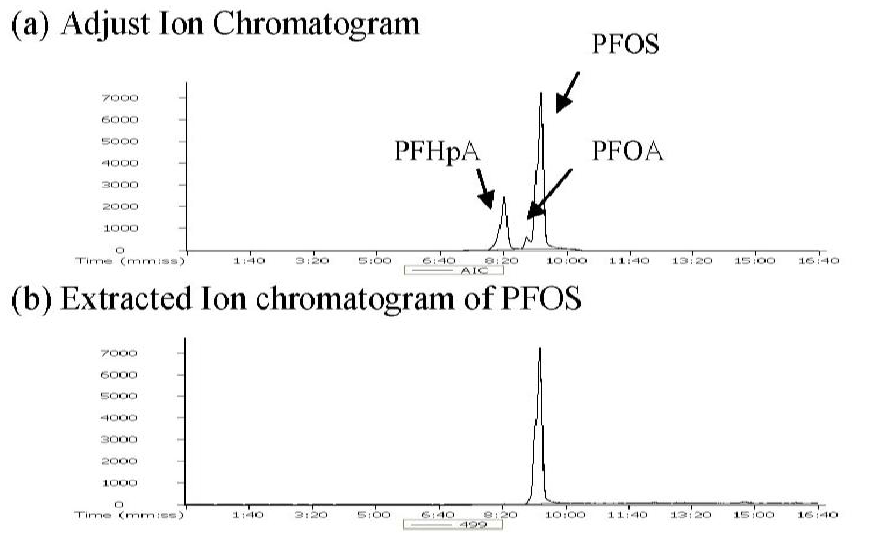
Figure 2. ( a ) Adjusted ion chromatogram and extracted chromatograms of ( b ) PFOS; ( c ) PFOA, ( d ) PFHpA (ISTD) from standard